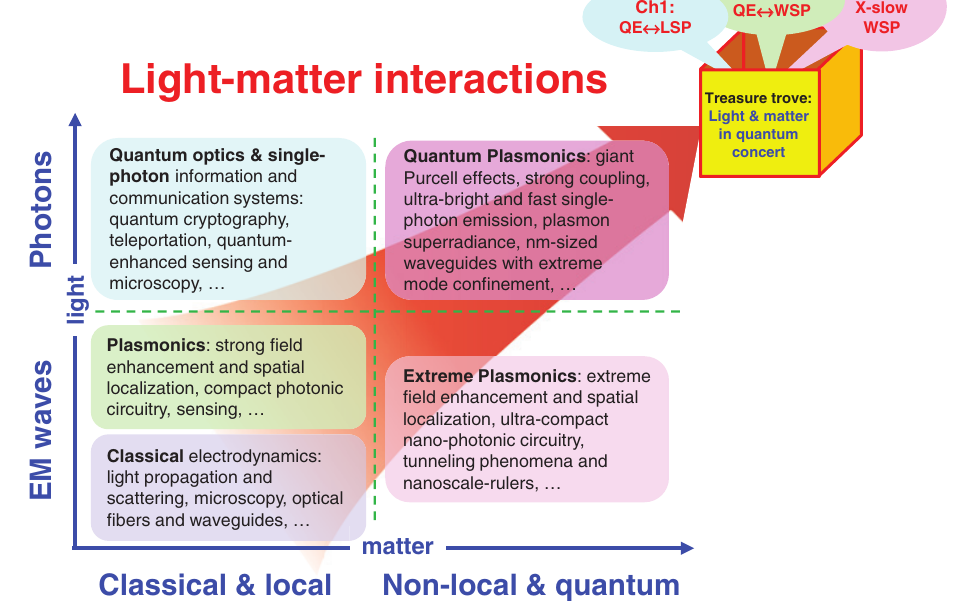
Figure 1: Quantum aspects of plasmonics exhibit both in the quantum nonlocal response of matter and in the quantized light fields. With the developments of quantum plasmonics, we anticipate a “treasure trove” of emerging quantum technologies that harvest from the quantum concert of both light and matter. In the main text, we outline three challenges associated with